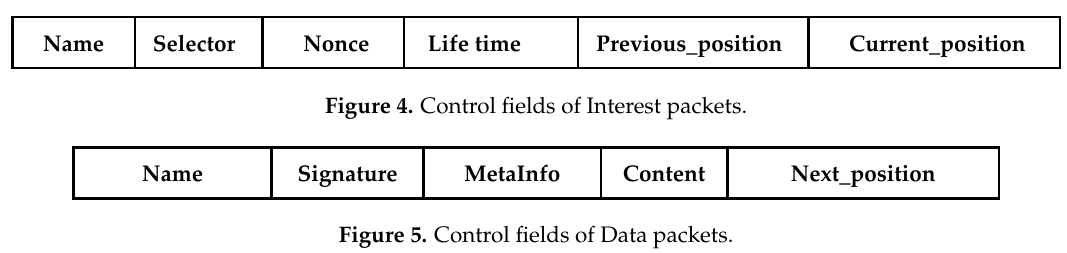
Figure 5. Control fields of Data packets.